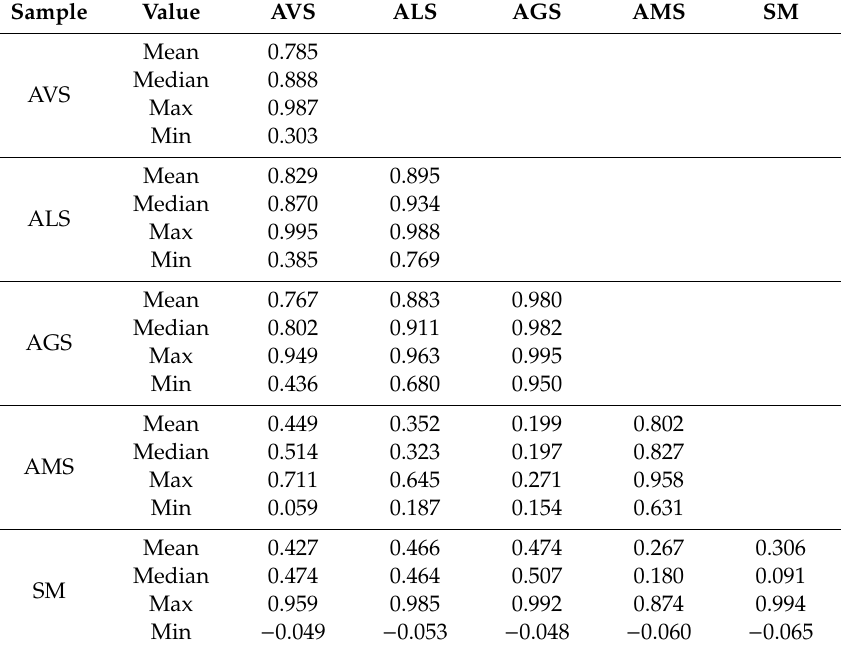
Table 4. Summary of Pearson’s correlation coe ffi cients of Amomi Fructus samples.